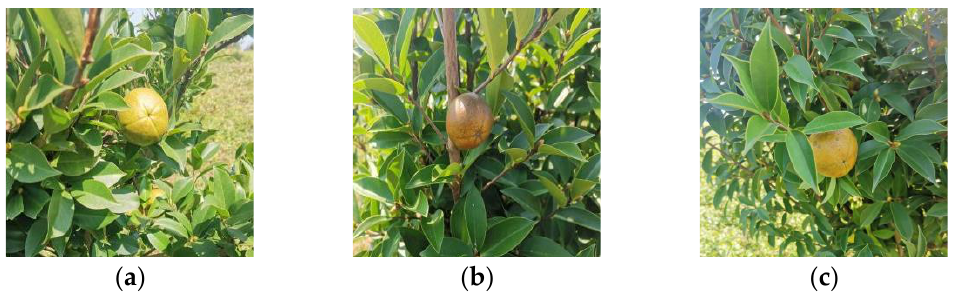
Figure 2. Camellia oleifera fruit. ( a ) Frontlighting, ( b ) Backlight, ( c ) Partial occlusion.